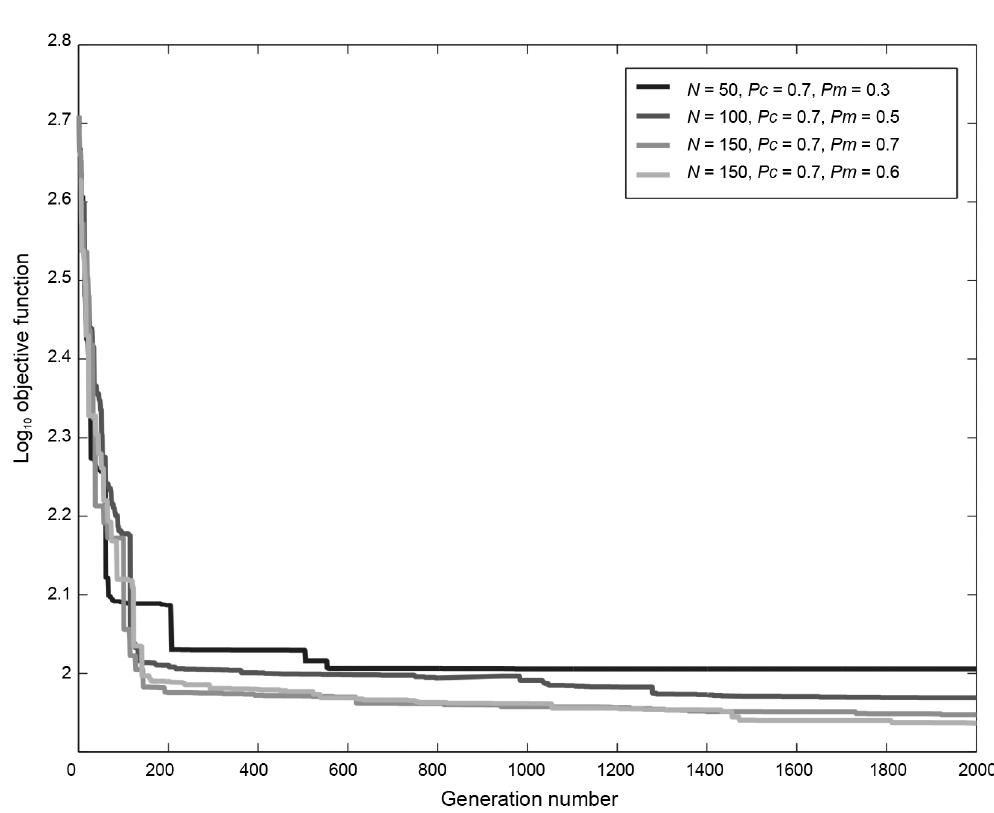
Fig. 4. Testings on GA setting parameters. The population converges toward the minimum of the objective function from its initial random distribution in the parameter